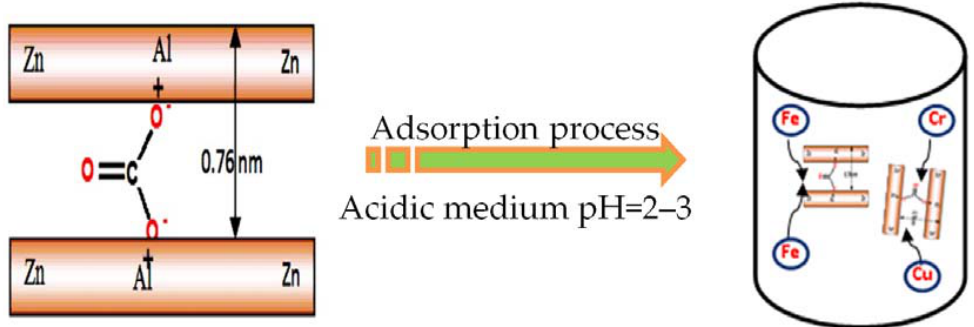
Figure 3. Adsorption process for purifying water from heavy metals in an extremely acidic medium.